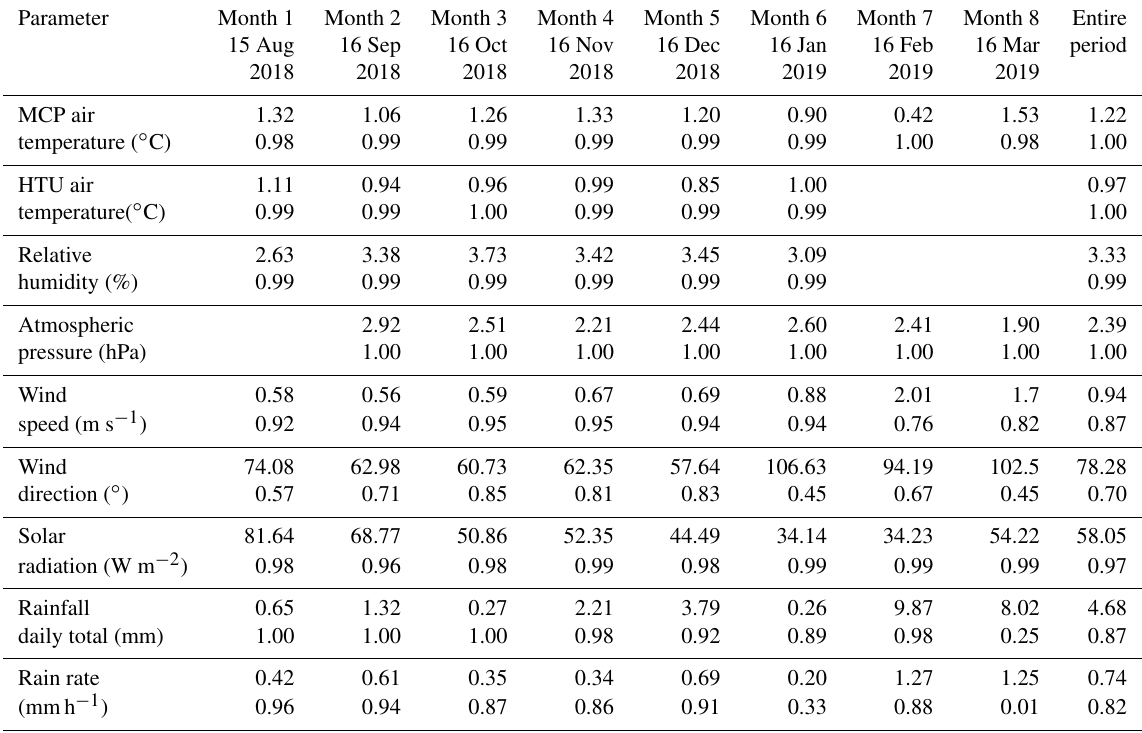
Table 4. Comparison statistics summary of RMSE (top value) and correlation coefficient (bottom value). Parameter